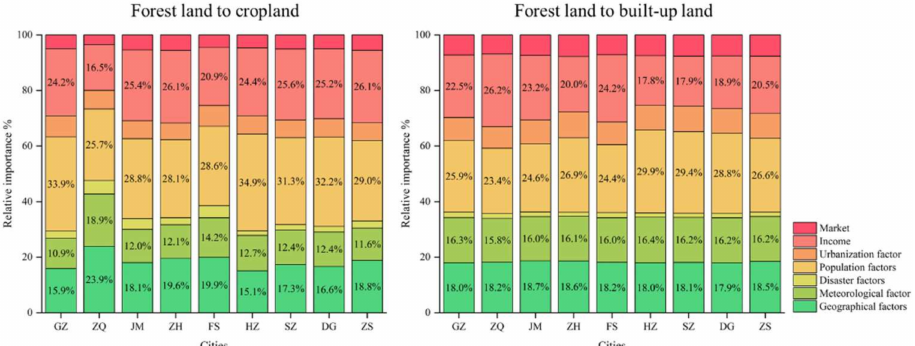
Figure 5. The relative importance of different factors in different cities for deforestation.